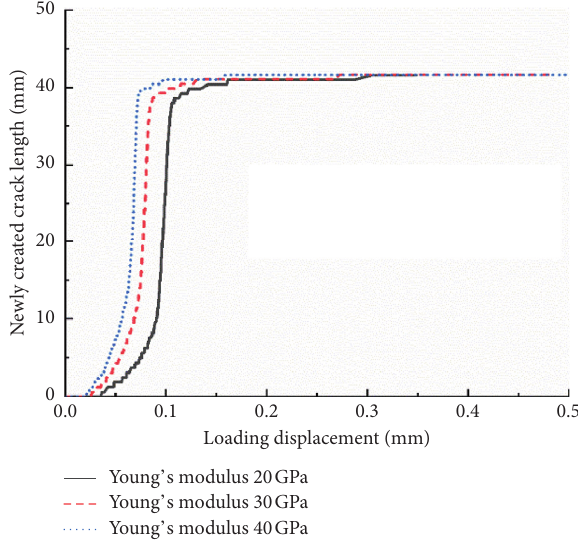
Figure 12: Effect of Young’s modulus on the crack length development.